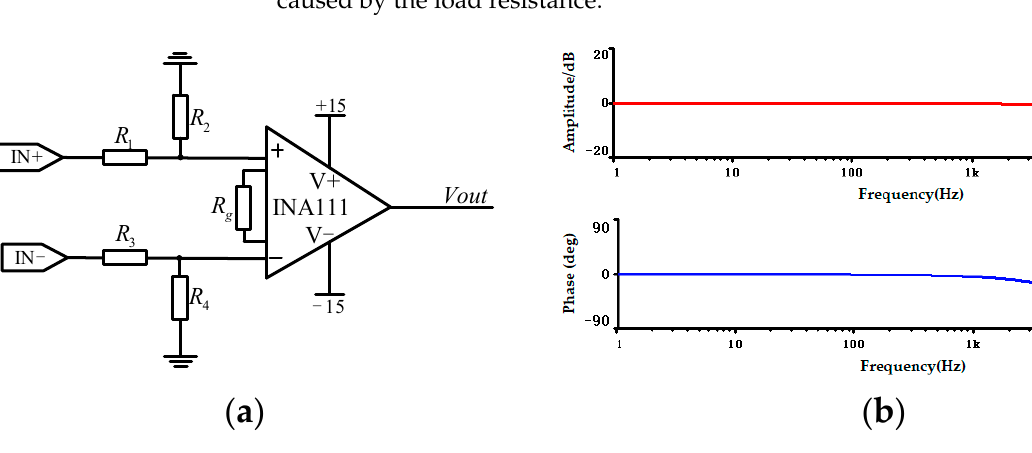
Figure 8. Back-end signal processing circuit: ( a ) Equivalent circuit; ( b ) Frequency response curve.